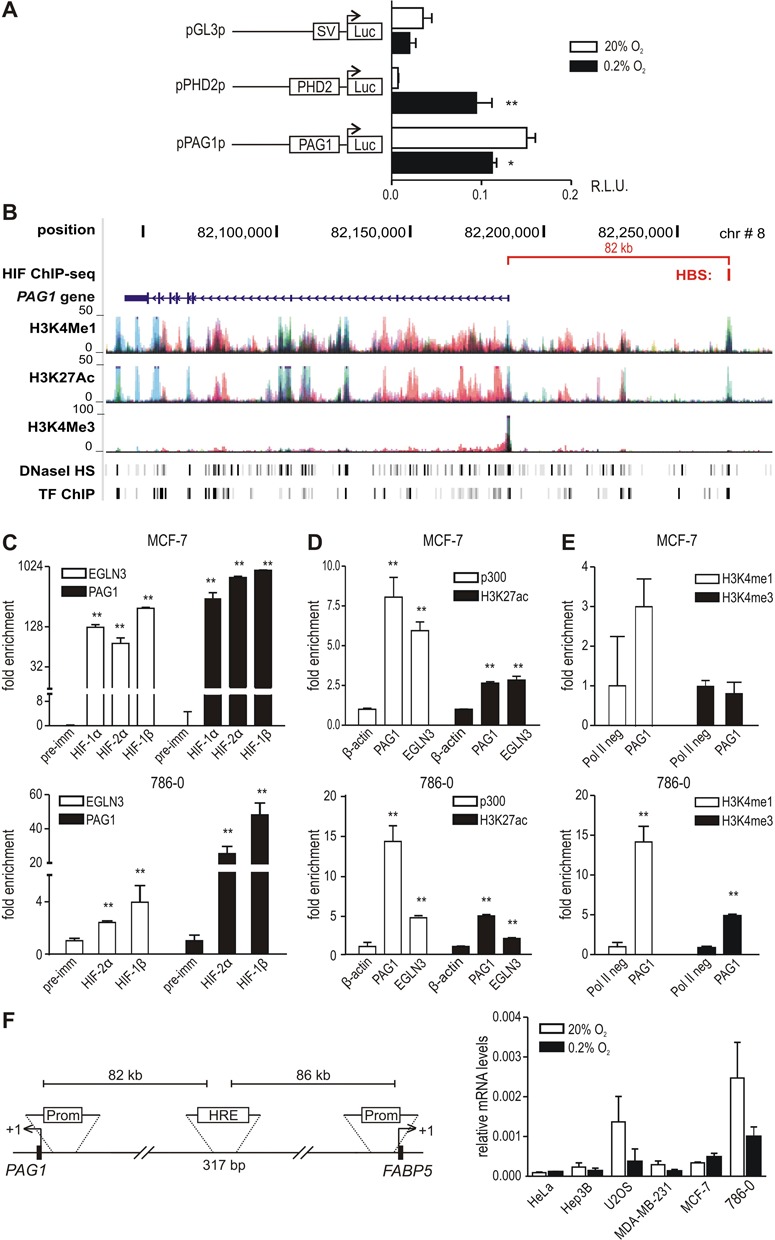
Identification of a HRE 82 kb upstream of the PAG1 TSS. (A) A PAG1 promoter-driven firefly luciferase reporter gene was transiently co-transfected into HeLa cells followed by exposure to 20% O2 or 0.2% O2 for 24 h. An SV40 promoter and a PHD2 promoter-driven luciferase vector served as negative and positive controls, respectively. Results are displayed as ratios of firefly to Renilla luciferase activities in relative light units (R.L.U.) from three independent experiments performed in triplicates, error bars correspond to the SEM. Statistical analyses were performed with unpaired Student's t-tests (*P < 0.05; **P < 0.01). (B) UCSC Genome Browser output (hg18) of the PAG1 genomic region, illustrating the location of the putative −82 kb HRE. In addition, the ENCODE integrated regulation track containing H3K4Me1/3 marks, H3K27Ac marks, DNaseI hypersensitivity clusters and transcription factor ChIP-seq data are displayed. Colors in the histone mark tracks represent conventional ENCODE codes used to illustrate different cell lines. (C-E) ChIP-qPCR of normoxic 786–0 cells and hypoxic (0.5% O2, 16 h) MCF-7 cells using antibodies directed against HIF-1α, HIF-2α, HIFβ, p300 and histone modifications H3K27Ac, H3K4Me1 and H3K4Me3. The HRE of EGLN3/PHD3, located in the first intron, served as positive control. Statistical analyses were performed with one-way ANOVA and Dunnet's correction for multiple comparisons (*P < 0.05; **P < 0.01). (F, left panel) Scheme depicting the location of the putative −82 kb HRE between the TSSs of PAG1 and FABP5. (F, right panel) The indicated cell lines were exposed to 20% O2 or 0.2% O2 for 24 h and FABP5 mRNA levels were quantified by RT-qPCR and shown relative to β-actin mRNA levels (n = 3).